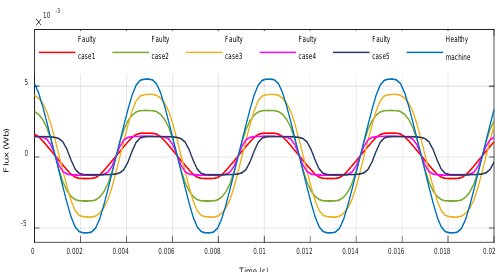
Figure 11. Flux linkage of the PMSM with 75% uniform demagnetization under different cases.